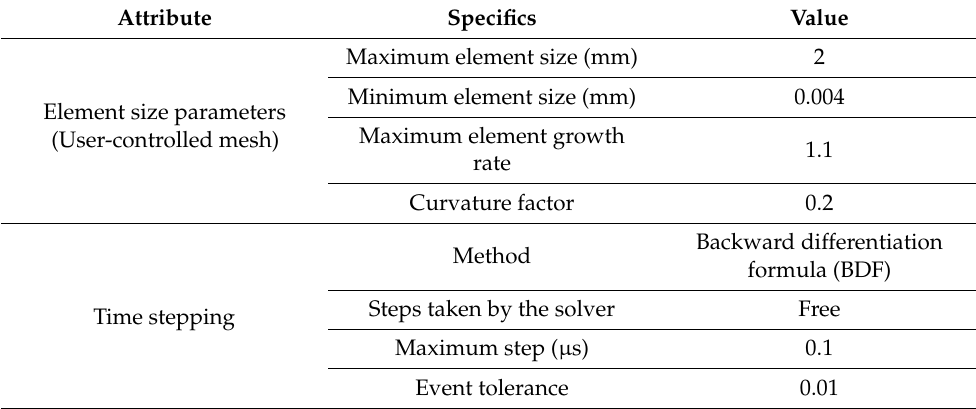
Table 3. Details of the FEM.